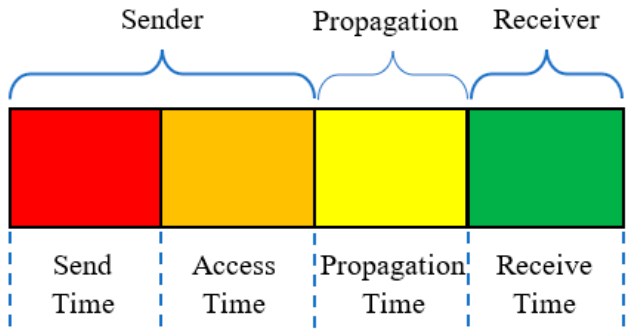
Figure 1. Packet delay components.